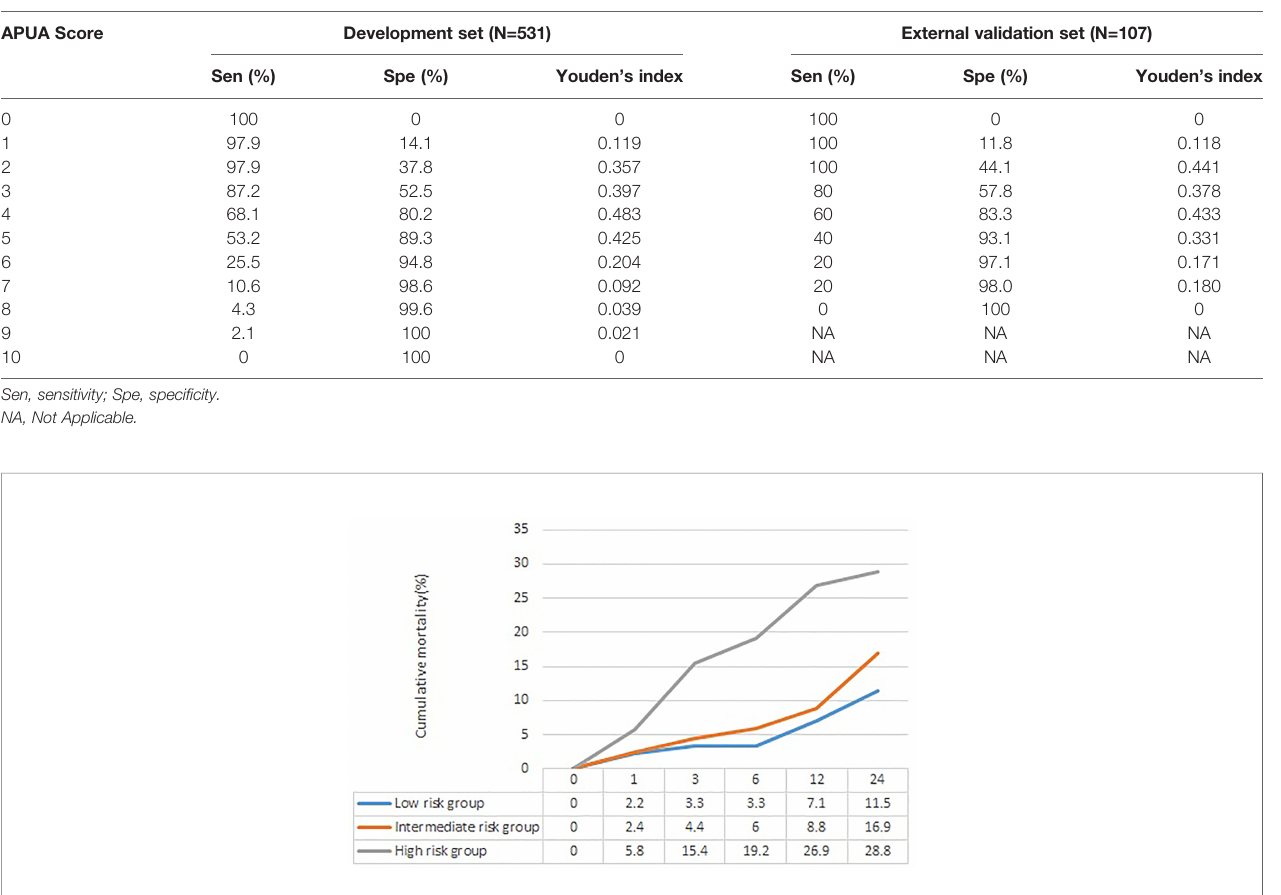
TABLE 5 | Cox proportional hazards regression analysis of risk strati fi cation of APUA score and long-term outcome in community acquired pneumonia patients with type 2 diabetes. APUA score 24-month mortality [n(%)] Model 1